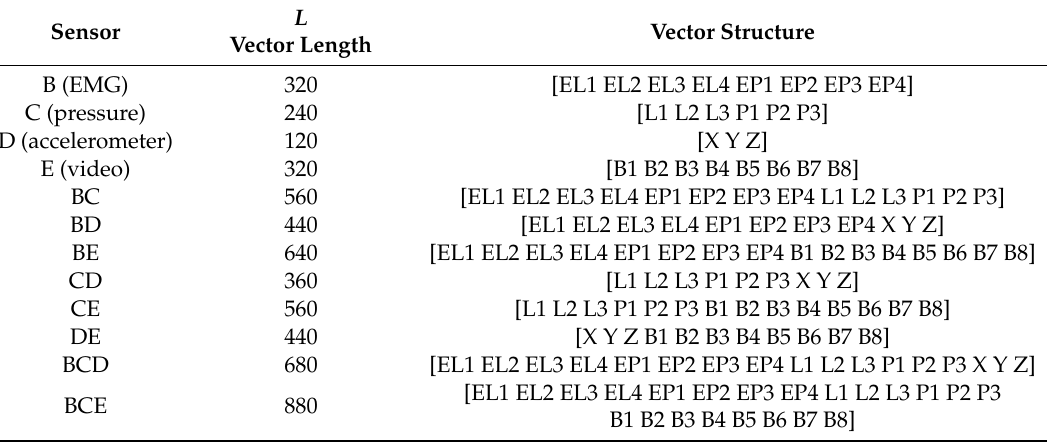
Table 2. Vectors for classification of the selected motor